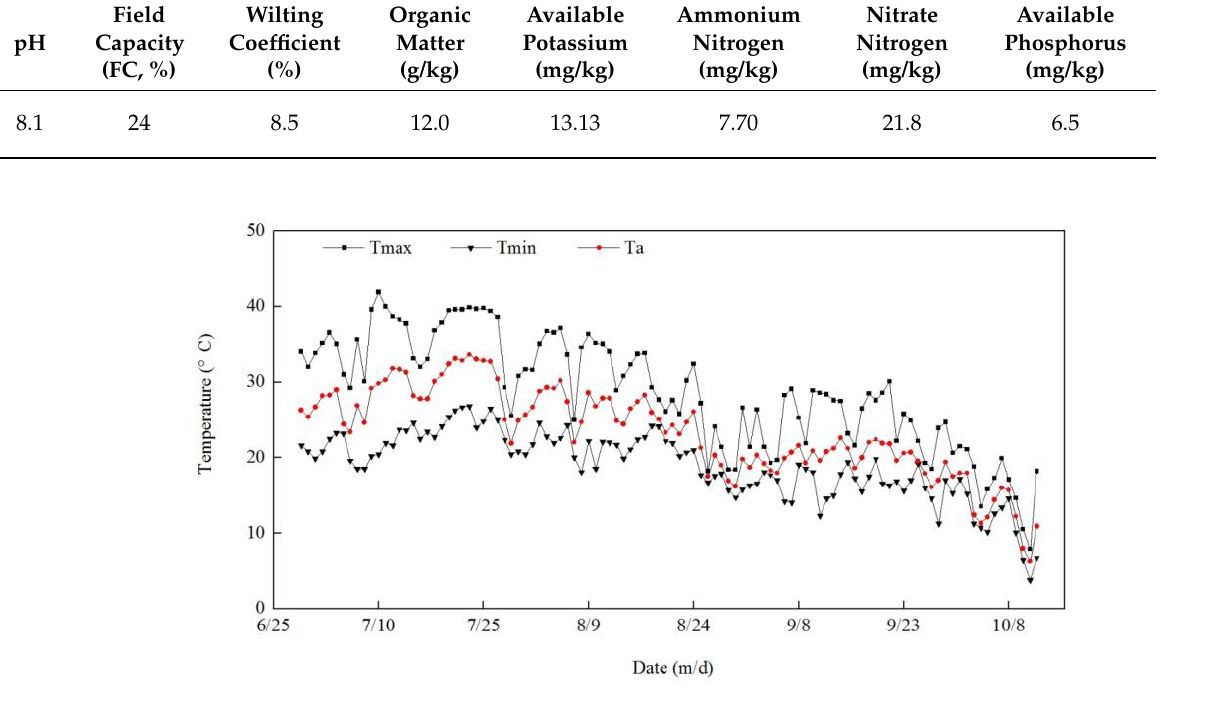
Figure 1. Daily air temperatures (T max = maximum air temperature, T min = minimum air temperature, and T a = average air temperature) during the maize growing season in 2017.